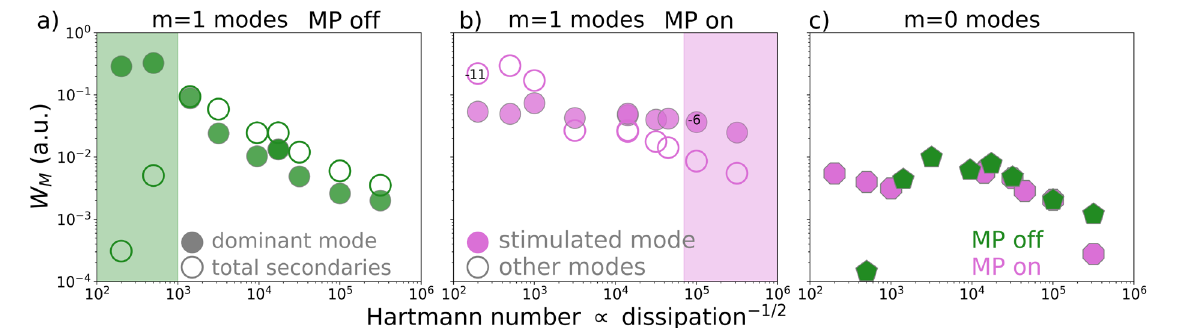
Figure 3. Scaling of the magnetic energy associated to the dominant and secondary MHD modes with the Hartmann number. Panel a shows the behaviour of m = 1 modes without applied MPs . Panel b): m = 1 modes with applied MPs on m = 1, n = -6, MP % = 4%. Panel c) focus on m = 0 modes. Two shaded regions where QSH states can be predicted are found: a green one at very high dissipation (panel a), with spontaneous 2D helical states, and a fuchsia one at low dissipation only when MPs are turned on (panel b). The toroidal mode number of the dominant mode is indicated inside some full circles. The behaviour of m = 0 MHD modes, to be compared with previous results in [41] also confirm the presence of these two regions. Intermediate regions ( H 10 3 ) instead do not correspond to helical ∼ solutions.